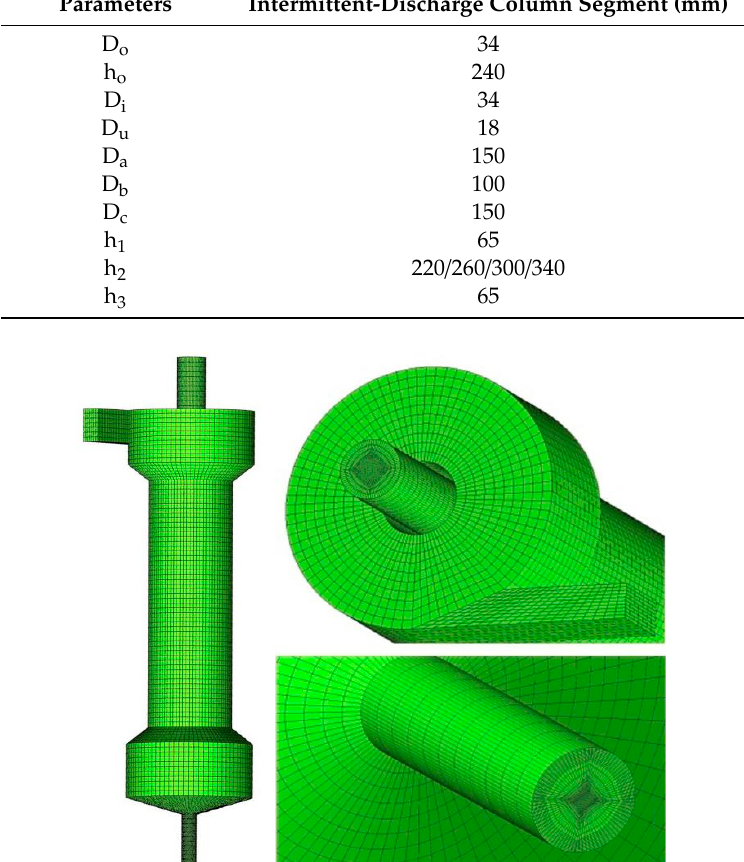
Figure 4. Mesh generation. Table 2. Structural parameters of the hydrocyclone.